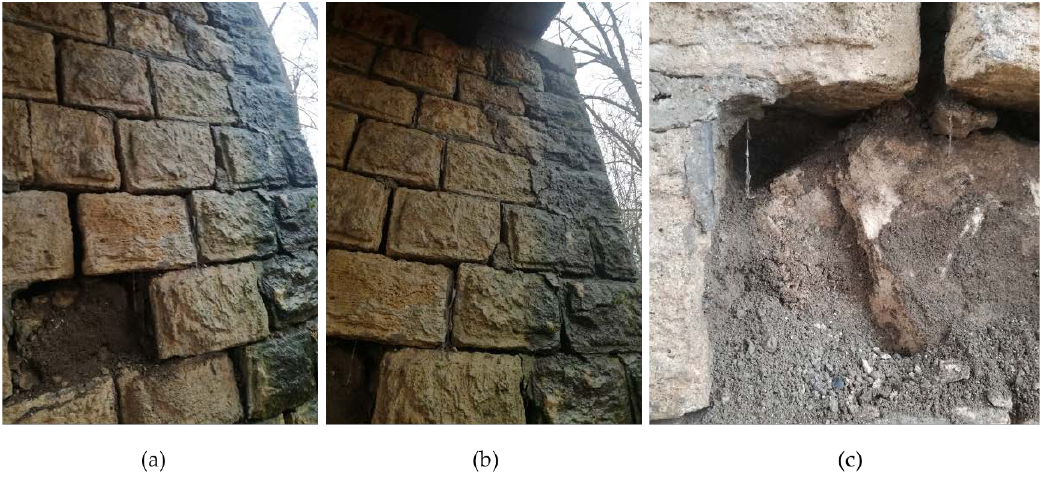
Figure 14. ( a ) and ( b ) Damage to the masonry walls of the abutment; ( c ) escarpment of infill material from the abutment. the